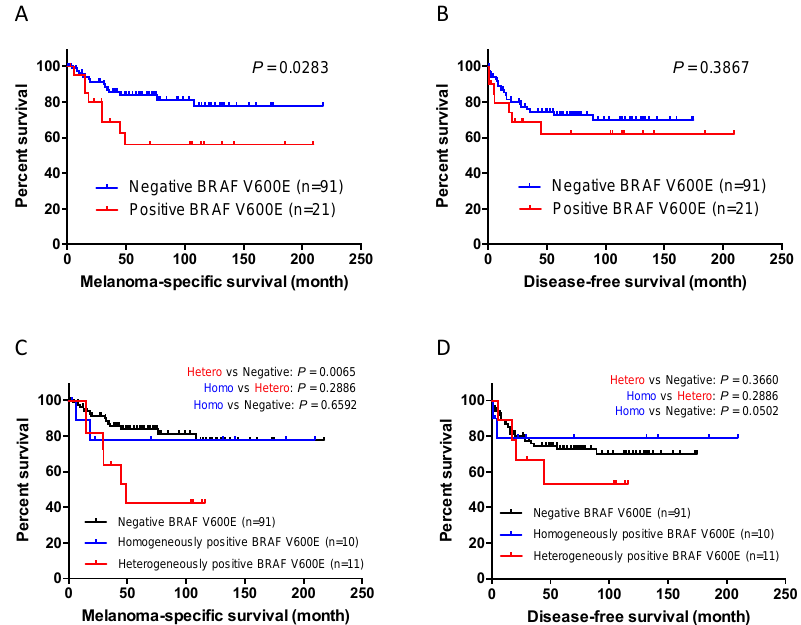
Figure 4. Kaplan–Meier survival curves for melanoma-specific survival (MSS) and disease-free survival (DFS). ( A ) Patients with BRAF V600E-positive acral melanoma had significantly shorter MSS than those with BRAF V600E-negative melanoma ( p = 0.0283, log-rank test; 5-year MSS, 56.1% and 83.9%, respectively). ( B ) In contrast, BRAF V600E positivity was not a significant prognostic factor for DFS ( p = 0.3867). ( C ) When BRAF V600E-positive melanoma was divided into heterogeneous and homogeneous subgroups, patients with heterogeneous acral melanomas had worse survival than those with BRAF-negative melanomas ( p = 0.0065, log-rank test). ( D ) There was no significant difference in DFS among the three